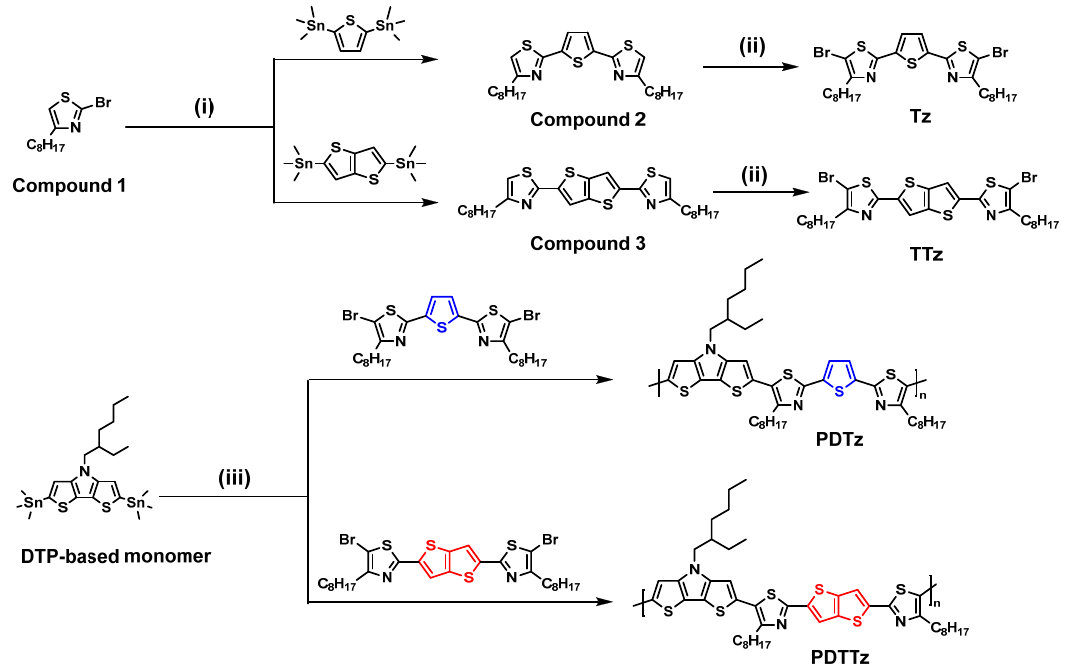
Scheme 1. Synthesis of monomers and polymers. Reaction conditions: ( i ) Pd 2 (dba) 3, P(o-tolyl) 3 , toluene, 110 ◦ C, procedure 24 h ( ii ) DMF, NBS, RT, overnight ( iii ) Pd(PPh 3 ) 4 , toluene, 110 ◦